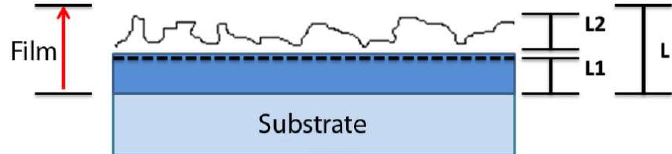
Figure 6. Model of the copolymer film thorough spectroscopic ellipsometry analysis (L1: dense layer, L2: rough layer).